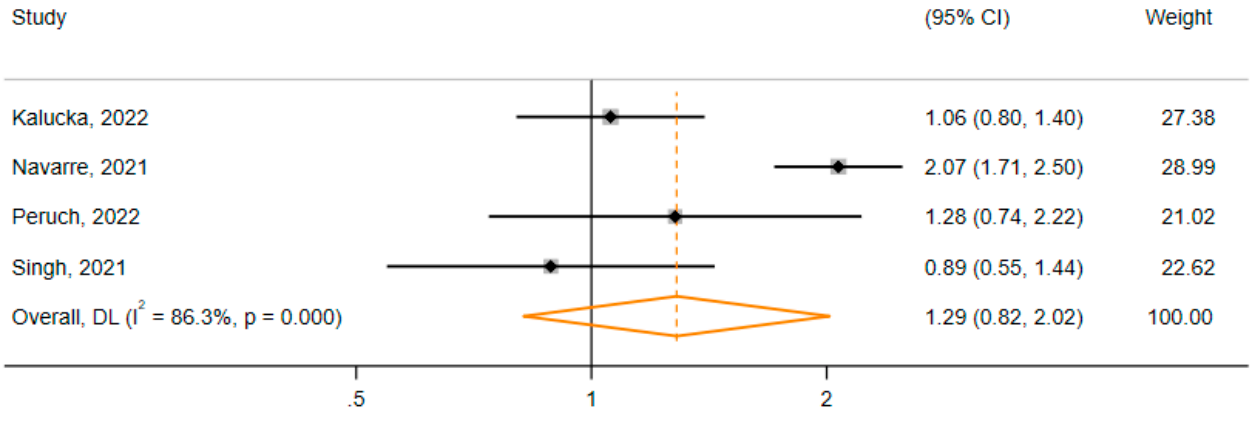
Figure 7. Relationship between physicians and other HCWs regarding the acceptance of COVID-19 vaccine mandates for HCWs [52,56,57,65]. vaccine mandates for HCWs